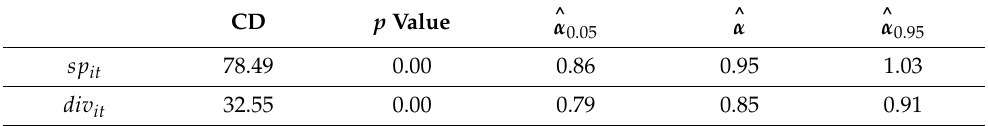
Table 1. Pesaran (2015) CD test and Bailey et al. (2016) bias-corrected exponent of cross-section dependence. CD p